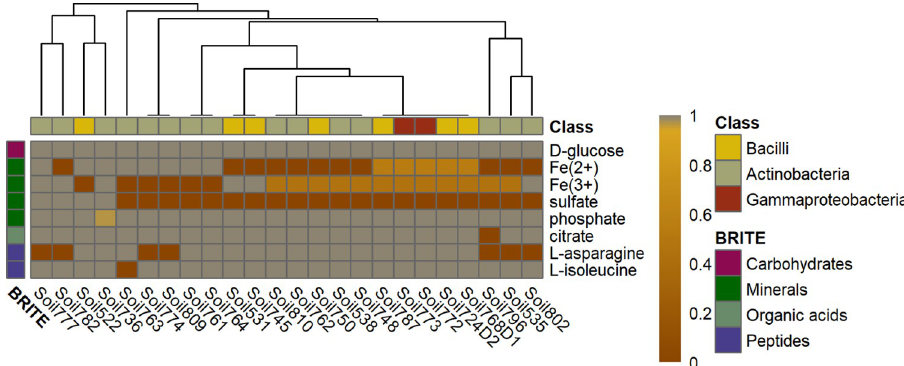
Fig 6. Reduction of biomass flux upon blocking the uptake of metabolites whose import was added during conditional gap filling of the Schlaeppi community. The uptake of every metabolite whose uptake was included during conditional gap filling was blocked separately and the growth rate under this condition was divided by the growth rate for that particular model. A threshold of 0.99 was applied to avoid false-positive responses. Biomass flux ratios were calculated for all metabolic models in the Schlaeppi community. The models were annotated to classes based on the taxonomy published by Bai et al. [38]. The metabolites were grouped based on KEGG BRITE br08001, which was manually refined. Hierarchical clustering was performed using average linkage with Euclidean distance. Cells in dark red indicate low biomass whereas yellow cells indicate a smaller reduction of